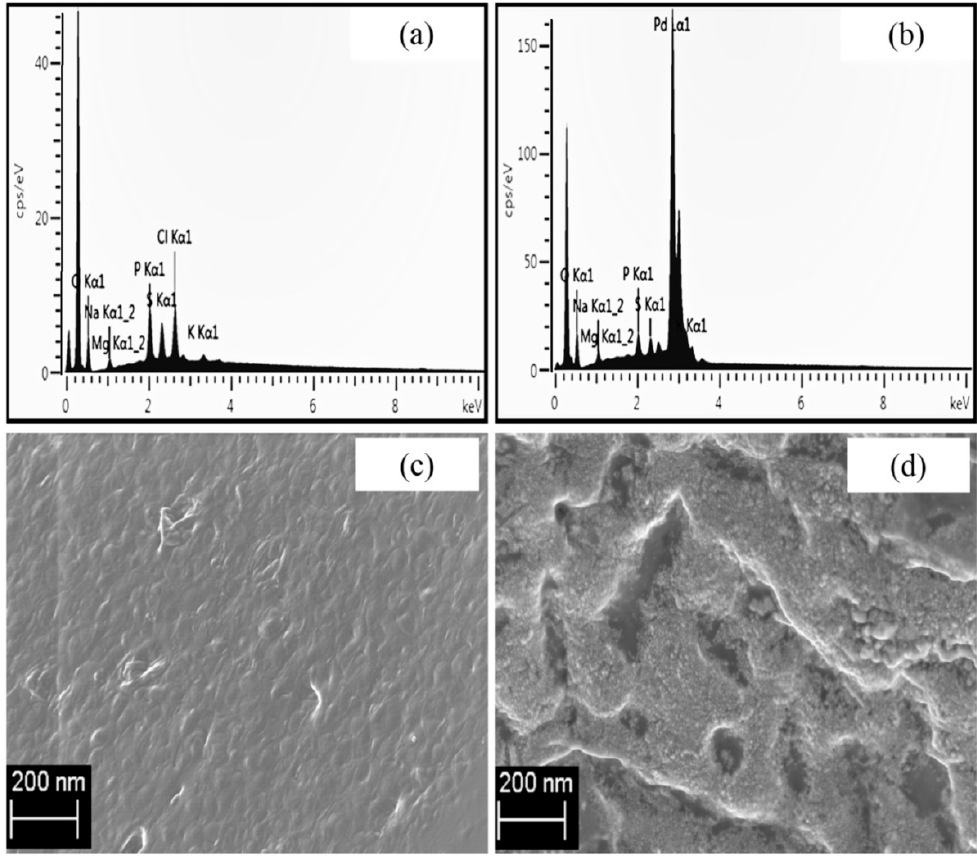
Figure 8. Elemental composition analysis by EDS of ( a ) Citrobacter sp. cells before Bio-PdNPs synthesis ( b ) and after Bio-PdNPs synthesis, both samples were oven dried at 105 °C; Scanning Electron Microscope (SEM) images showing morphology of ( c ) Citrobacter sp. cells before Bio-PdNPs synthesis ( d ) and after Bio-PdNPs synthesis, both samples were oven dried at 105 °C.